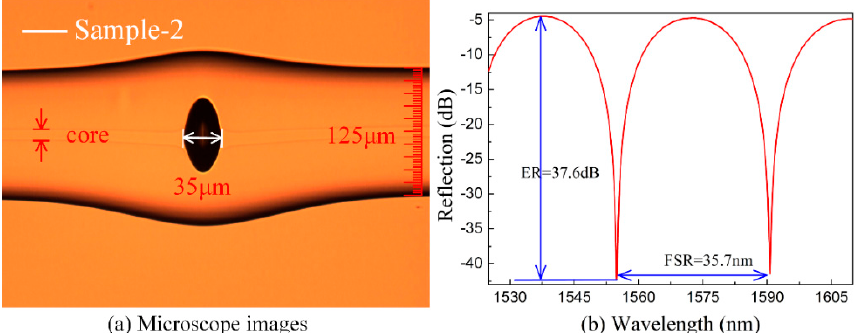
Figure 2. ( a ) Microscope images of the in-fiber FPI with a cavity length of ~35 µ m. ( b ) The corresponding reflection spectrum of the FPI, free spectral range (FSR) ~35.7 nm, ER ~37.6 dB.